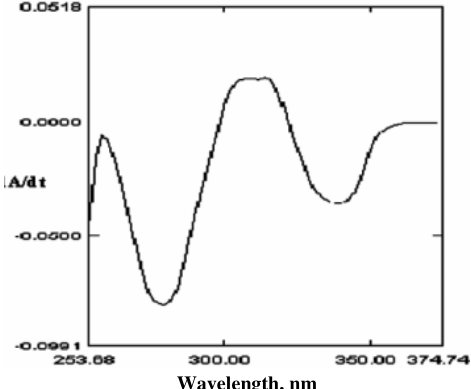
Figure 2. First order derivative spectrum of nabumetone (30 µ